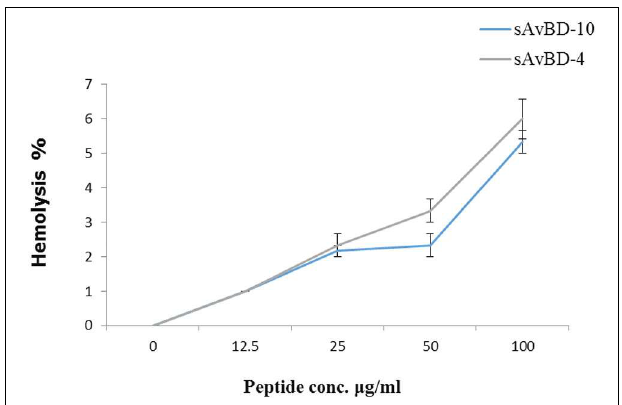
FIGURE 4 | Hemolytic activities of synthetic chicken β -defensin-4 and 10-derived peptides (sAvBD). All assays were performed in three independent experiments and each point is the mean ±